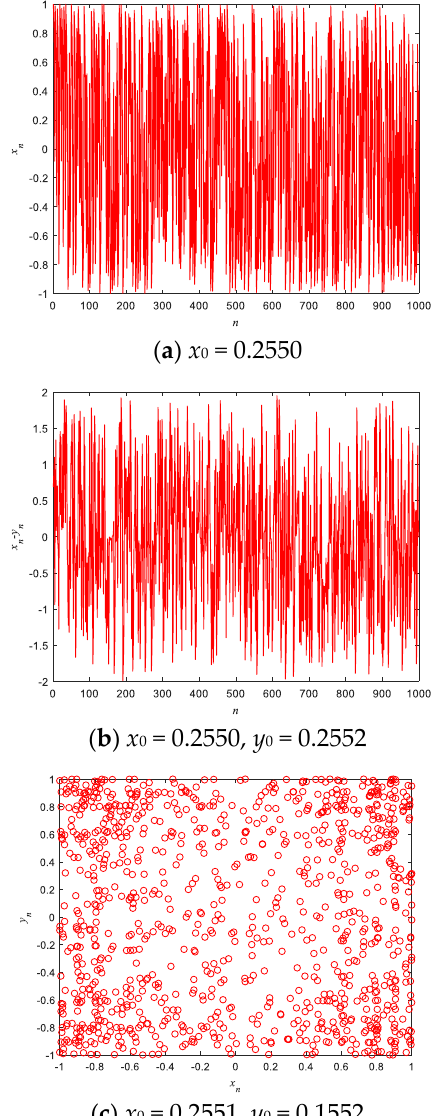
Figure 3. The relationship between Sin ’ s chaotic properties and the number of iterations.